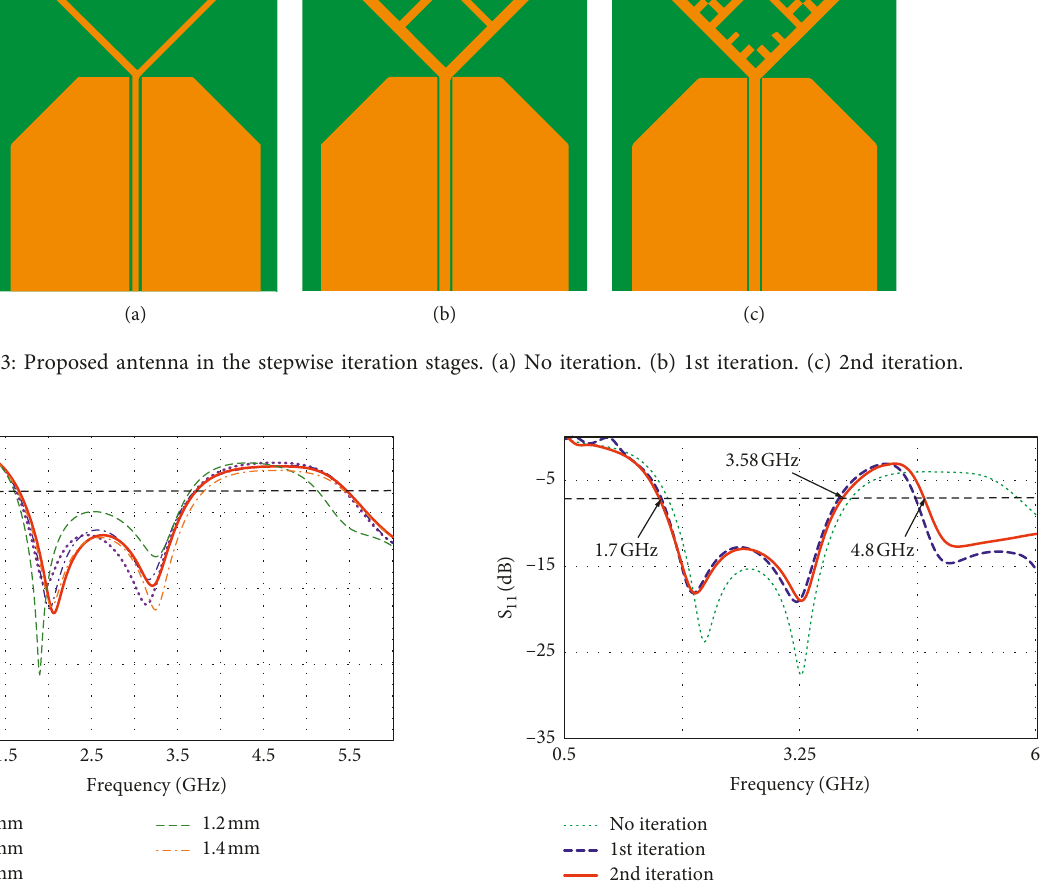
Figure 4: Performance comparison of basic radiators with different line widths.